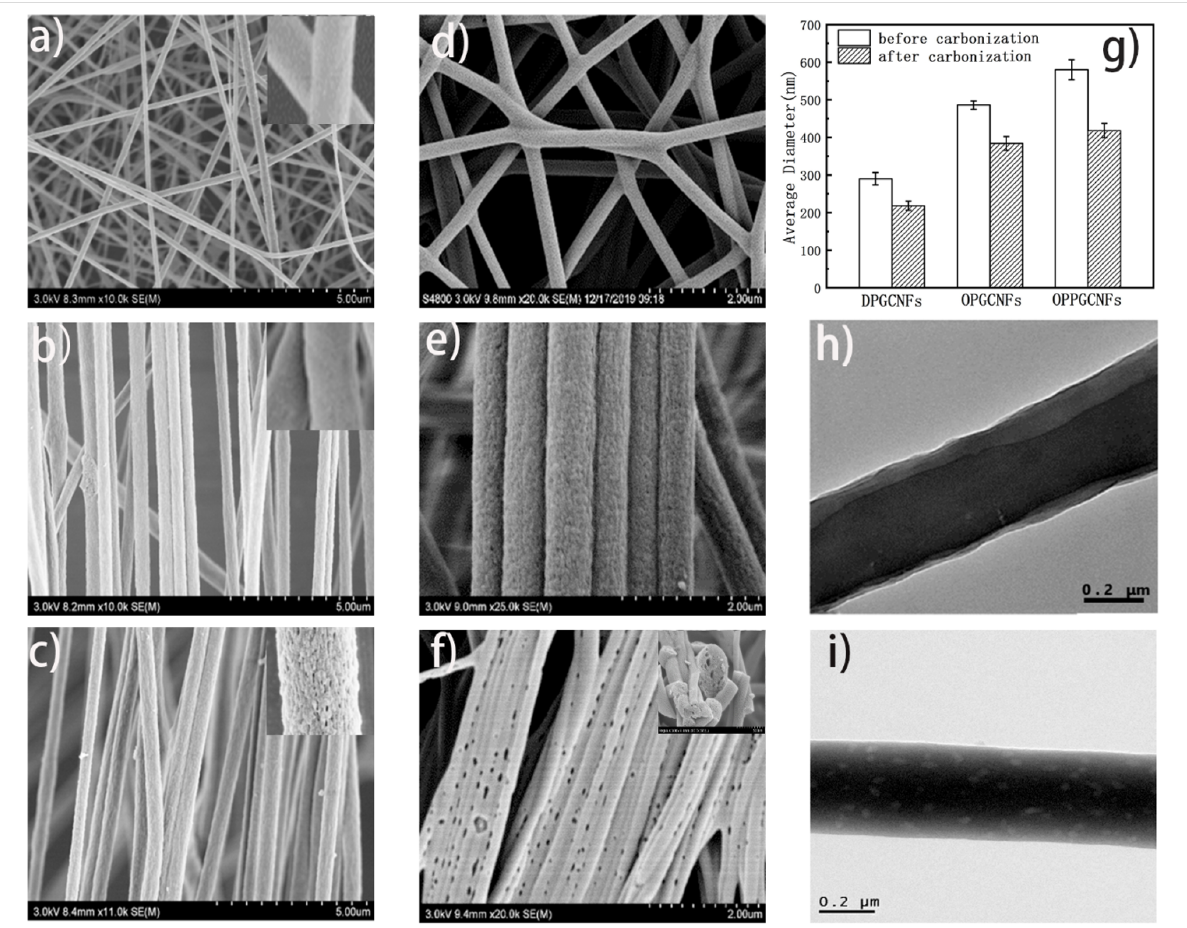
Figure 2: FE-SEM images of (a) disordered PGCNFs synthesized via electrospinning (DPGCNFs) with an average diameter of 289.9 ± 16.5 nm. (b) Ordered PGCNFs synthesized via MPEM (OPGCNFs), with an average diameter of 486.2 ± 11.1 nm. (c) Ordered porous PGCNFs synthesized via MPEM (OPPGCNFs), with an average diameter of 579.9 ± 26.6 nm. (d) Disordered CGCNFs (DCGCNFs), with an average diameter of 218.2 ± 12.2 nm. (e) Ordered CGCNFs (OCGCNFs), with an average diameter of 384.1 ± 18.5 nm. (f) Ordered porous CGCNFs (OPCGCNFs), with an average diameter of 418.4 ± 19.1 nm. (g) Average CNF nanofiber diameter values before and after carbonization. TEM pictures of PGCNFs (h) and CGCNFs